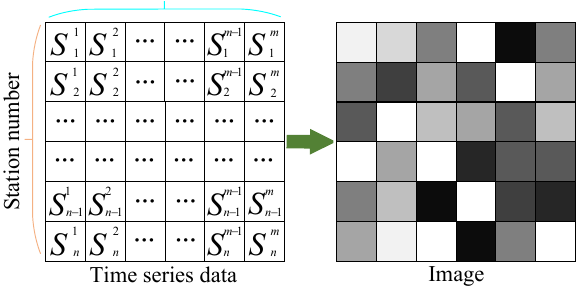
Figure 6. Visualization of electric field